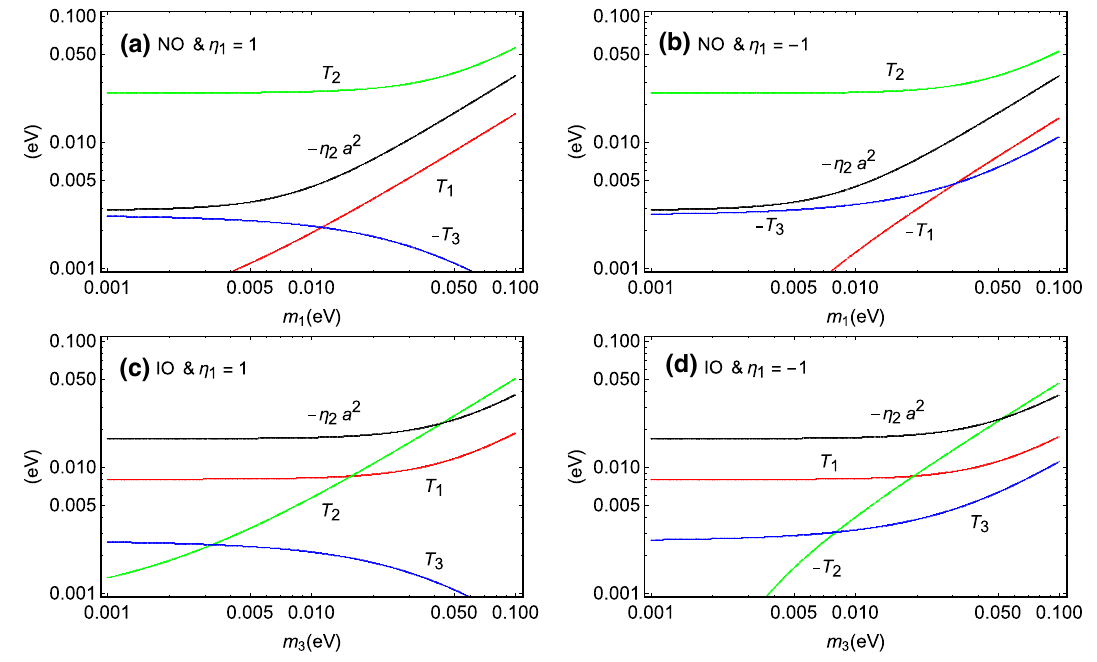
, T and T as functions of the lightest neutrino mass in the NO 1 2 3